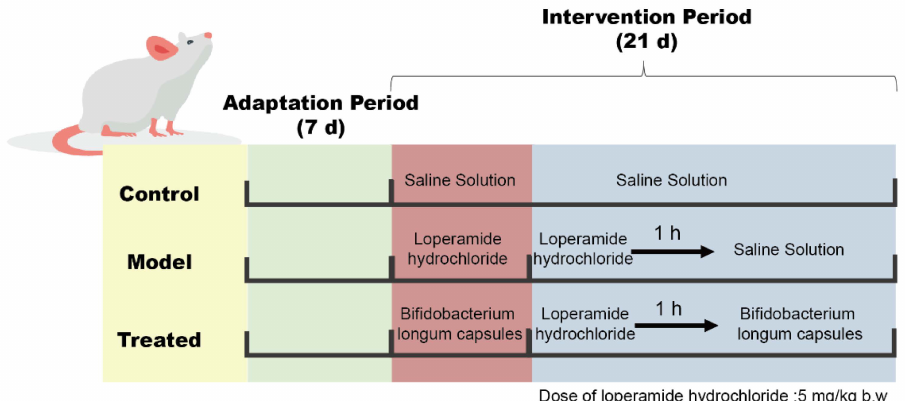
Figure 7. Animal experiment design